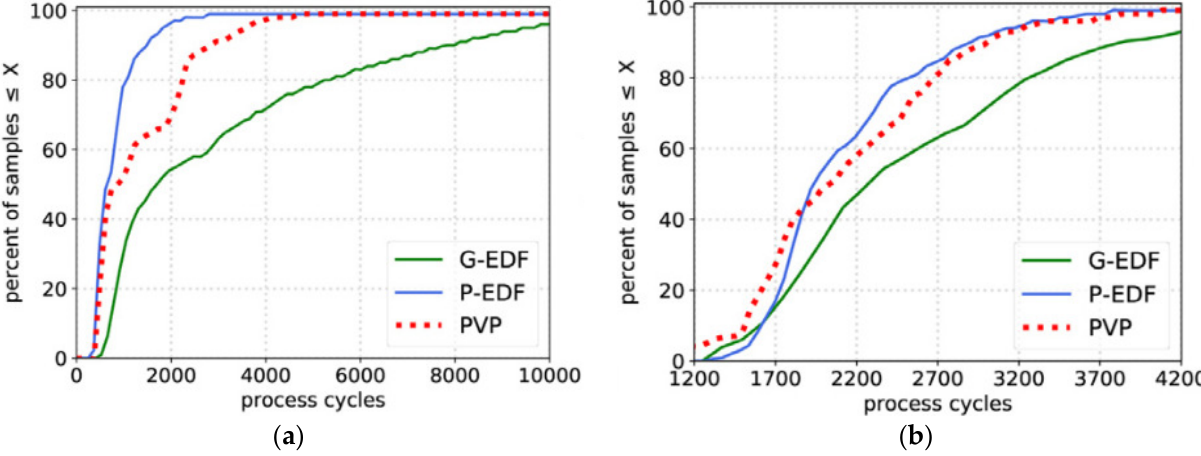
Figure 10. Comparison of three schedulers; ( a ) scheduling overhead, ( b ) context-switch overhead. Deadline and Period: Periods are generated in an integer power of 2. We find the minimum value A so that L i ≤ c , and casually set T i to one of 2 c , 2 c + 1 or 2 c + 2. When the period T i of the task is 2 c , 2 c +1 or 2 c +2, the ratio L i / T i of the task is in the range of [1, 1/2], [1/2, 1/4] or [1/4, 1/8] respectively. The relative cut-off time is uniformly selected from the range [ L i , T i ]